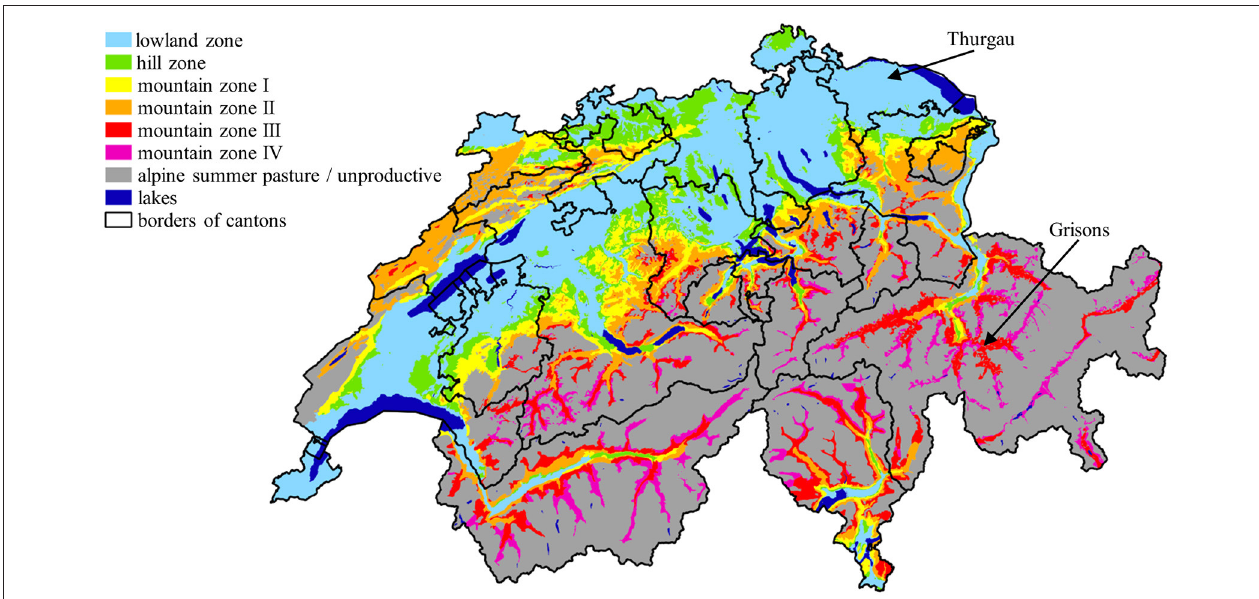
FIGURE 1 | Map of agricultural production zones in Switzerland and locations of the cantons Thurgau and Grisons, where the studied lowland and mountain farms were situated (Federal Office for Agriculture (FOAG), 2015; swisstopo, 2016).